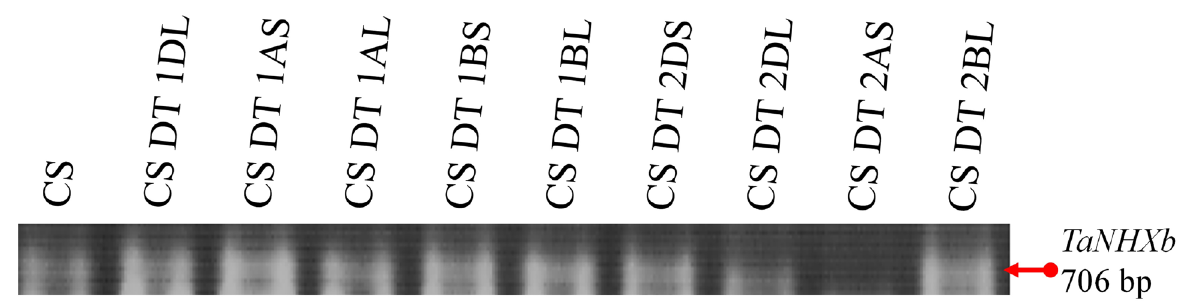
Figure 6 – Chromosomal localization of the wheat Na + /H + antiporter gene by using ditelosomic series. To determine the chromosome location of TaNHXb gene, specific primers were designed from 706 bp of intron 2 sequence, and PCR was conducted using genomic DNA from a series of ditelosomics of Chinese Spring as templates. The 706 bp band of TaNHXb was not found in a ditelosomic line lacking the short arm of chromosome 2A. Therefore, TaNHXb was localized on chromosome 2A. DT: